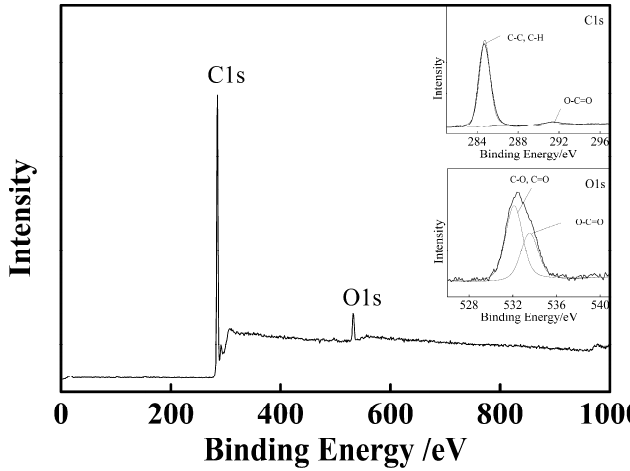
Figure 3. XPS spectrum of PSA0 nanospheres.